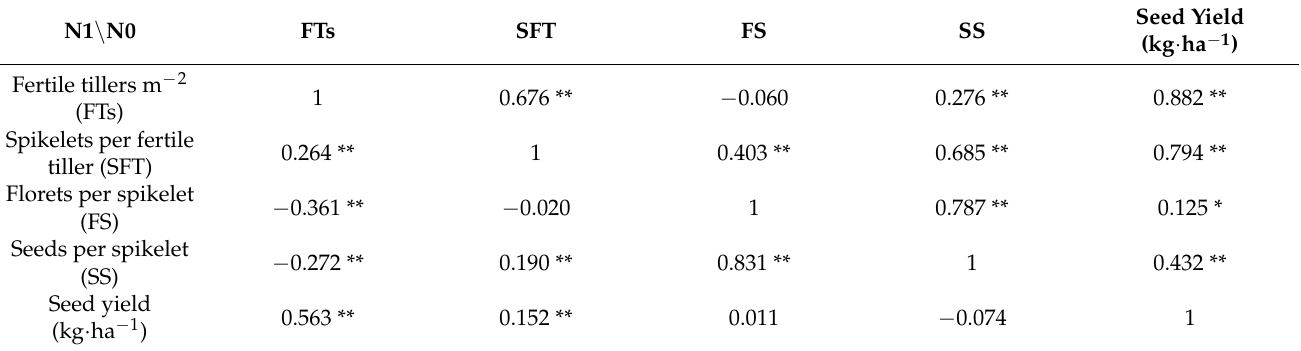
Table 7. Correlation analysis of seed yield and yield components in smooth bromegrass under N